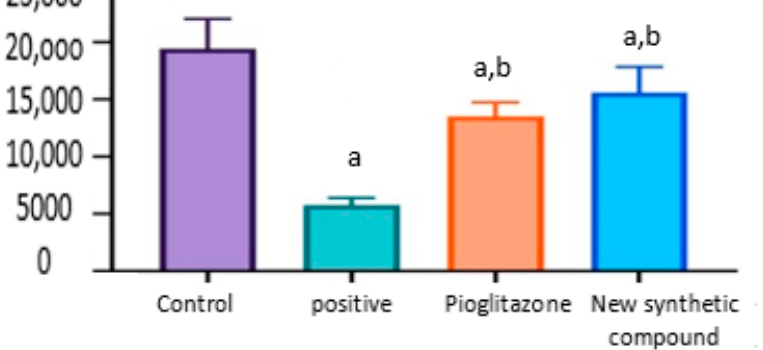
Figure 8. Photomicrographs of rat pancreatic sections stained with H&E showing the effect of 14 days of oral administration of pioglitazone and the synthetic compound against STZ-induced type 2 DM. ( a ) Normal control section (25 µ m) showing the normal structures of both exocrine units and endocrine components of the pancreas. The islets of Langerhans appeared to be of normal size and contained β -cells; ( b ) positive control group section (25 µ m) showing atrophied ill-distinct islets of Langerhans that contained few vacuolated and necrotic β -cells. Some of the examined sections exhibited inflammatory reactions in the peri-pancreatic tissue (black arrows); ( c ) pioglitazone treatment section (25 µ m) showing variable sized islets that showed few vacuolated cells. Some sections exhibited apparently normal endocrine components; ( d ) synthetic compound section (25 µ m) revealed normal structures of both the exocrine units and endocrine components of the pancreas. The islets of Langerhans appeared to be of normal size and contained β -cells (black arrow). The Langerhans islets area was decreased significantly in control positive group when compared to the other groups. Both pioglitazone and benzosulfonamide derivative groups showed significant increase in the islets in comparison with positive control group. Data were presented as mean ±SE. a: Significantly different from the normal control group, b: Significantly different from the positive control group at p < 0.05.